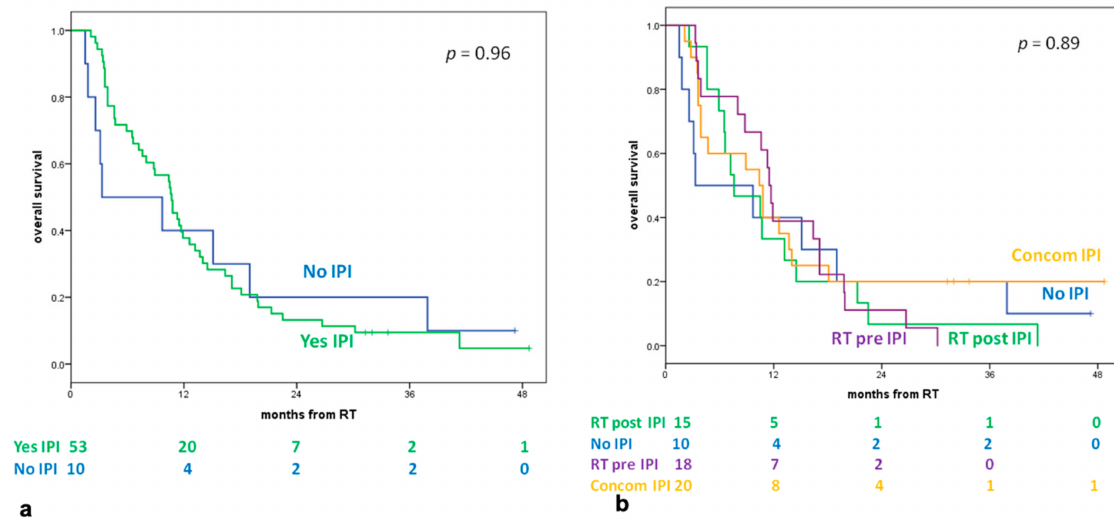
Figure 1. ( a ) Overall survival according to ipilimumab (IPI). ( b ) Overall survival according to four groups. Legend: